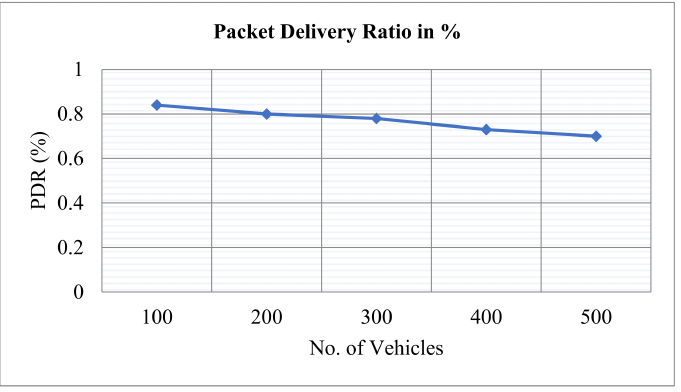
Figure 16. PDR for increase in vehicle density.